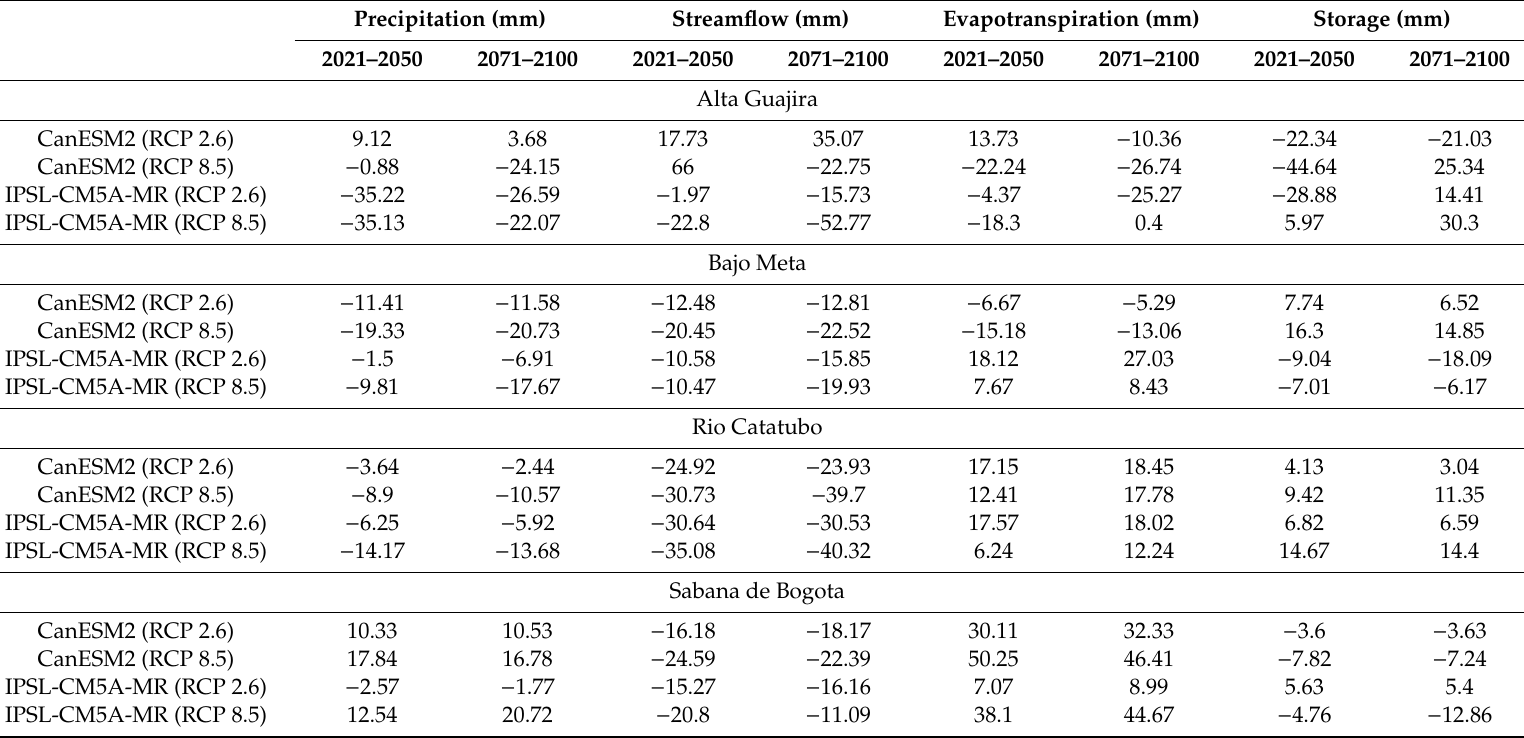
Table 2. Percentual change of the water-balance components in the projected